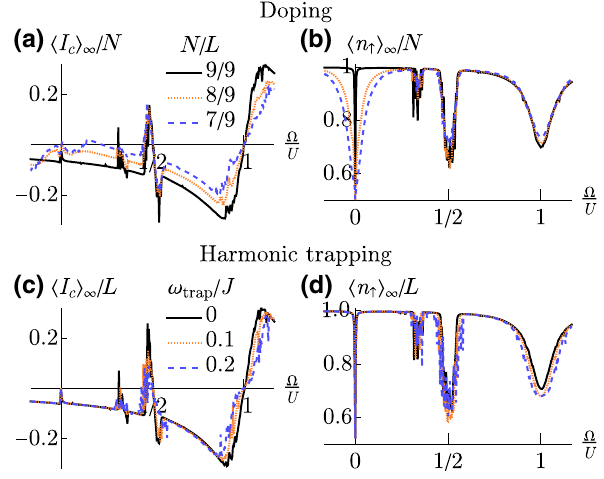
FIG. 12. (a) Average chiral current for the n = 2 system with holes in the initial state. The parameters are L = 9, U / J = 30, φ = π/ 2. Time averaging is done out to tJ = 500. The N / L = 8 / 9 curves have a single hole initially at lattice site j = 1, while the N / L = 7 / 9 curves have holes initially at sites j = 1, 3. (b) Average dressed state population for the same setup. (c) Average trap ˆ H trap . We use the same parameters as (a), except with